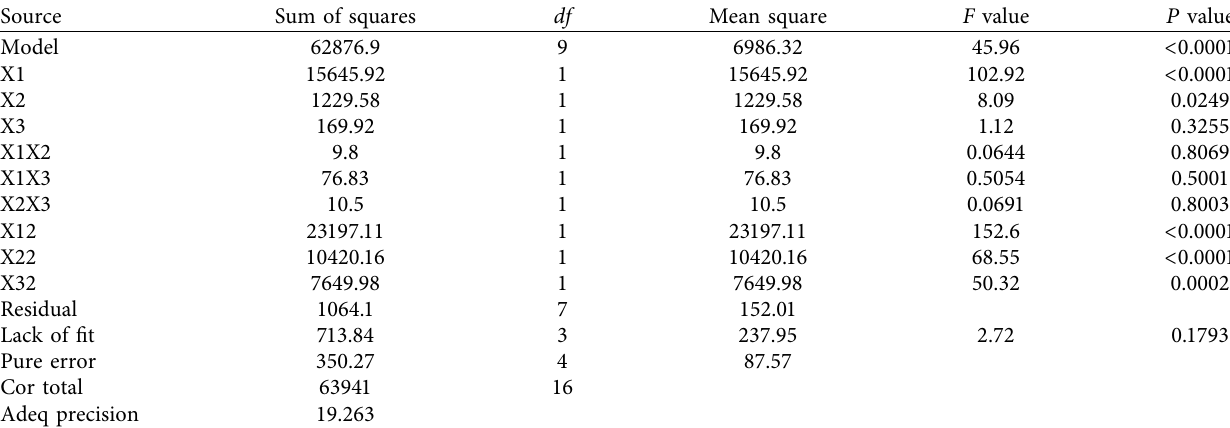
Table 3: ANOVA for the response surface quadratic model of antioxidants